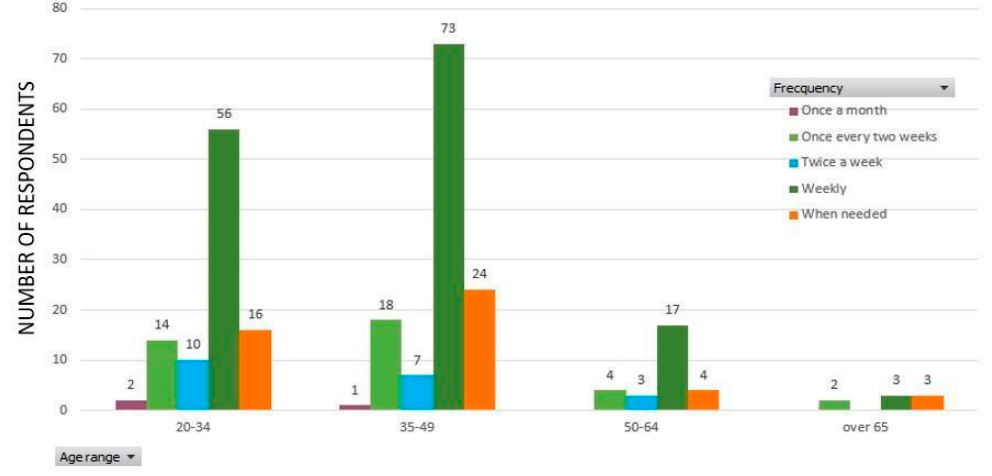
Figure 9. The preferred purchase frequency according to age groups.